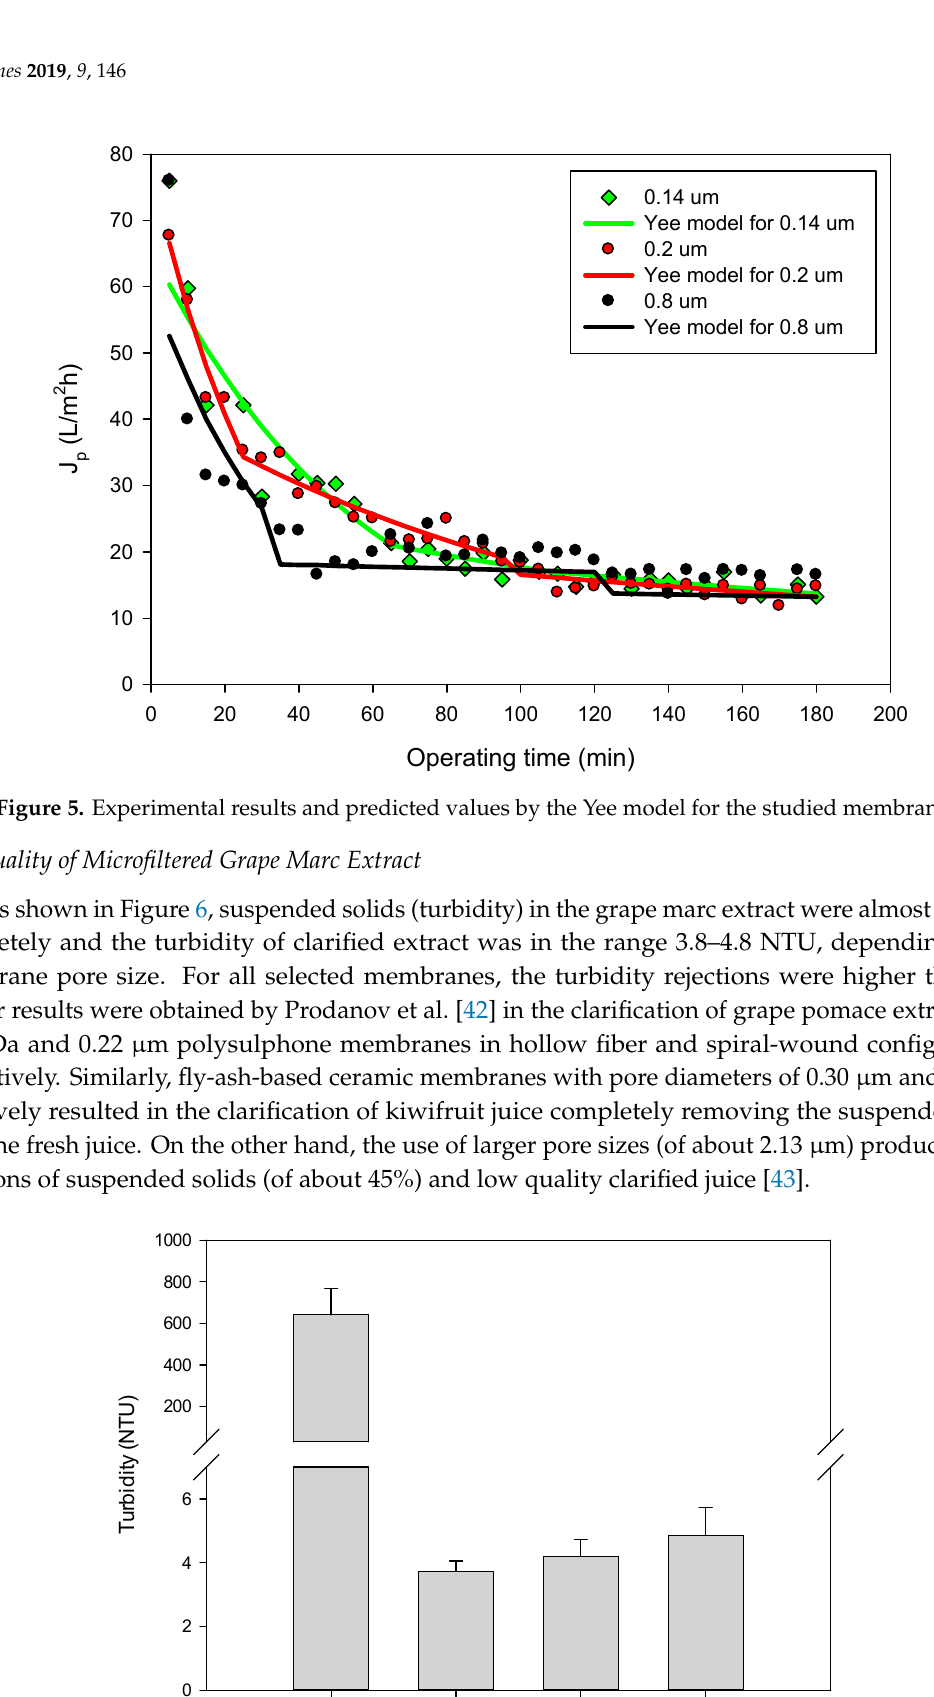
Figure 6. Suspended solids content in the grape marc extract (feed) and the permeate stream of investigated membranes.